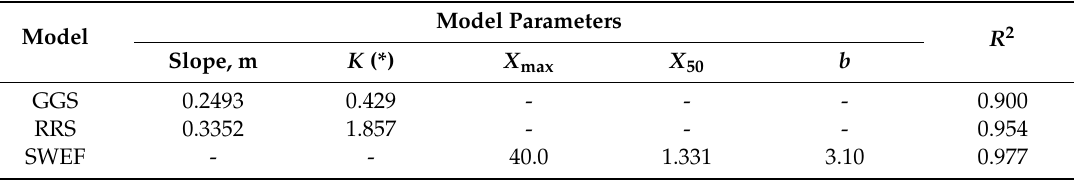
Table 3. Parameters of the distribution models under study.